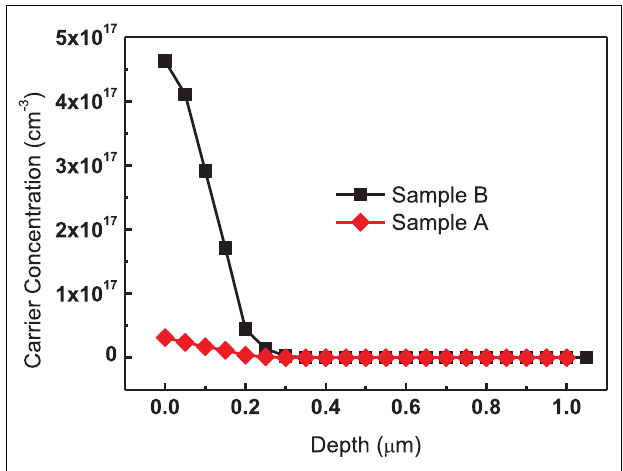
FIGURE 1 | Spreading resistance profile spectra of pn junctions made from SampleA and Sample B fabricated with two boron sources .